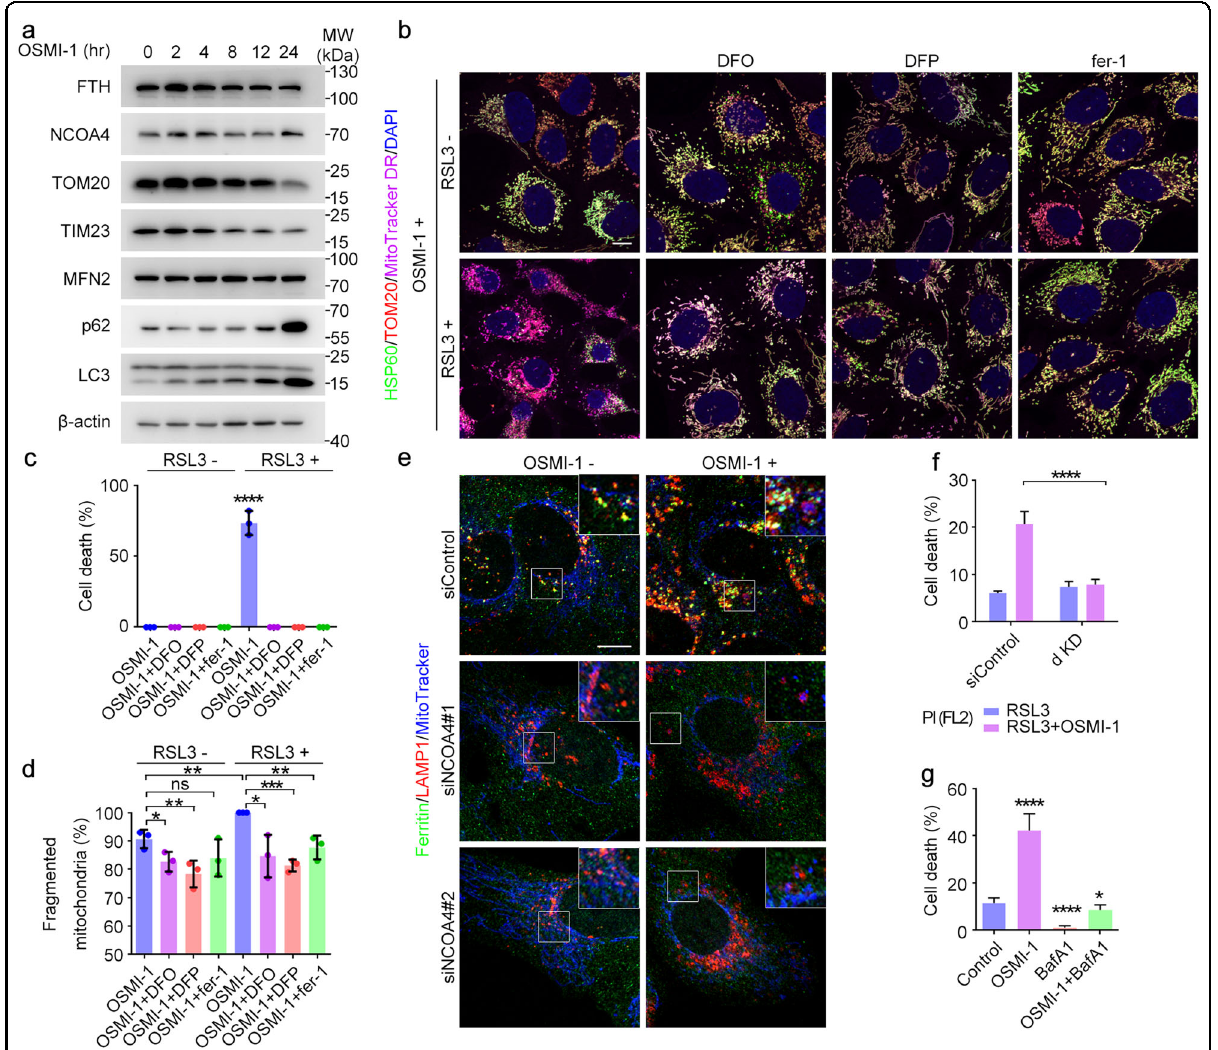
Fig. 5 O -GlcNAcylation-dependent ferritinophagy and mitophagy contribute to ferroptosis. a U2OS cells were treated with OSMI-1 for the indicated time and cell lysates were subjected to immunoblotting with indicated antibodies. b – d U2OS cells were incubated with OSMI-1 for 12 h, and treated with or without RSL3 for 6 h. Cells were stained with MitoTracker and subjected to immuno fl uorescence microscopy with antibodies against TOM20 and HSP60 ( b ). The percentage of dead cells ( c ) and fragmented mitochondria ( d ) were quanti fi ed. e U2OS cells were transfected with control or NCOA4 siRNAs for 48 h and treated with DMSO or OSMI-1 for 12 h. Cells were subjected to immuno fl uorescence microscopy with antibodies against ferritin and LAMP1. f U2OS cells were transfected with control or combination of PINK1 and NCOA4 siRNAs for 48 h and treated with DMSO or OSMI-1 for 12 h, and then induced with RSL3 for 3 h. Cells were stained with PI and assessed by fl ow cytometry. g U2OS cells were treated as indicated for 12 h and then induced with RSL3 for 3 h. Cells were stained with Trypan blue solution and the percentages of dead cells were quanti fi ed. Scale bars, 10 μ m. * P < 0.05, ** P < 0.01, *** P < 0.001, **** P < 0.0001; ns, not signi fi cant. Error bars indicate